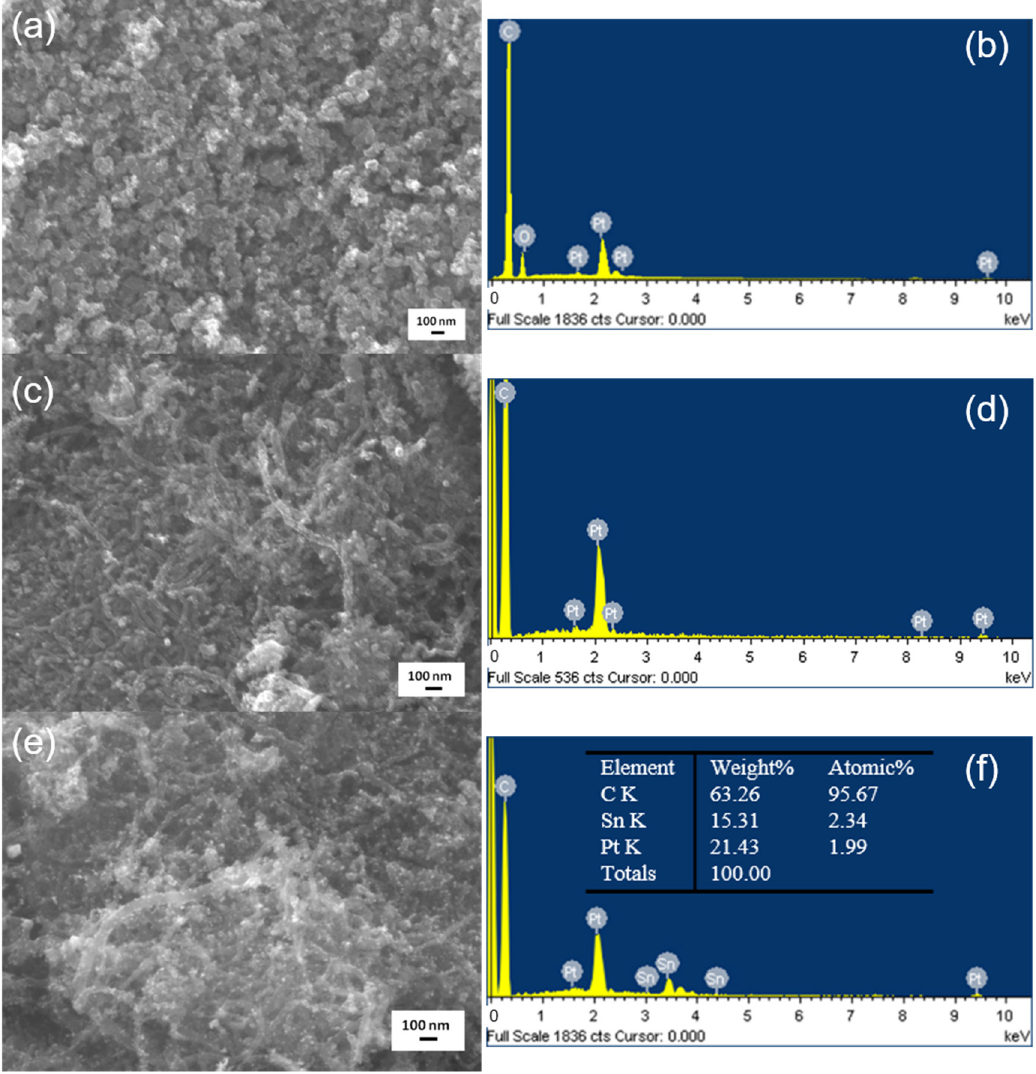
Figure 5. Scanning electron microscope (SEM) images and energy dispersive X ‐ ray (EDX) spectra of ( a , b ) Pt/XC ‐ 72; ( c , d ) Pt/PEI ‐ MWCNTs; and ( e , f ) PtSn/PEI ‐ MWCNTs.